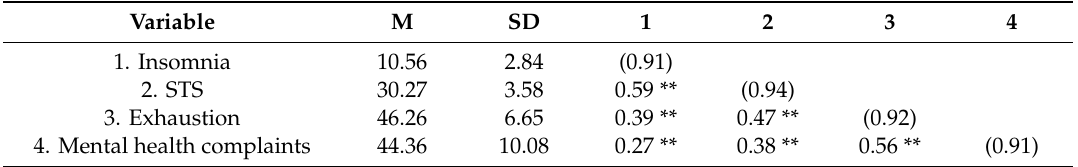
Table 2. Descriptive statistics, correlations, and scale reliabilities.